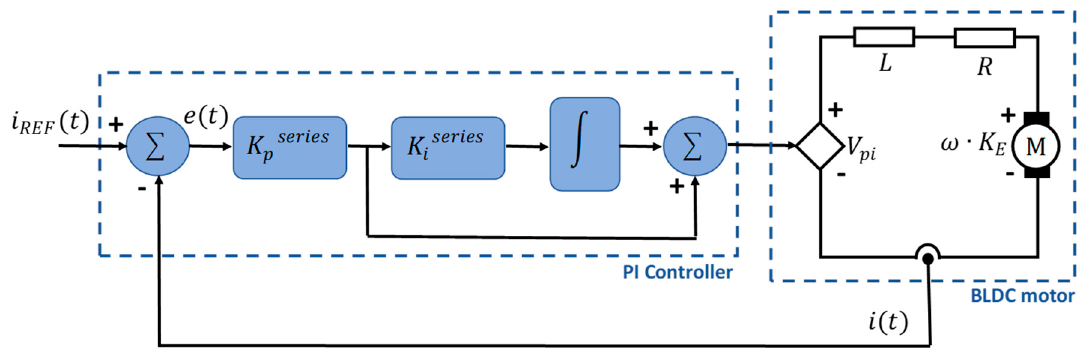
Figure 7. Current control loop and brushless-DC motor (BLDC) motor first order model.